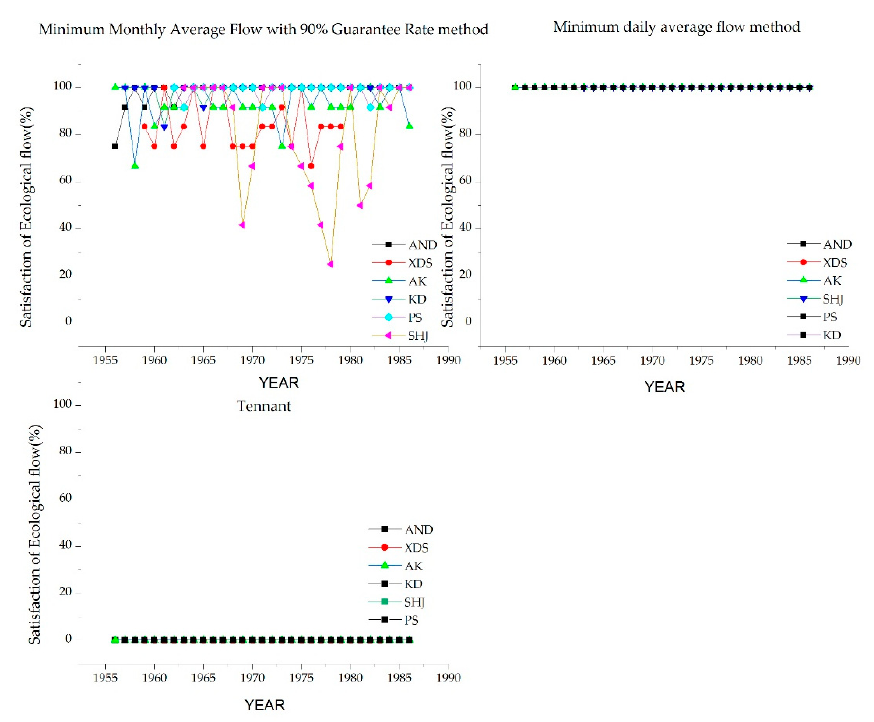
Figure 4. The assessment model results of different methods for the control hydrologic station in the mainstream section of the river basin.